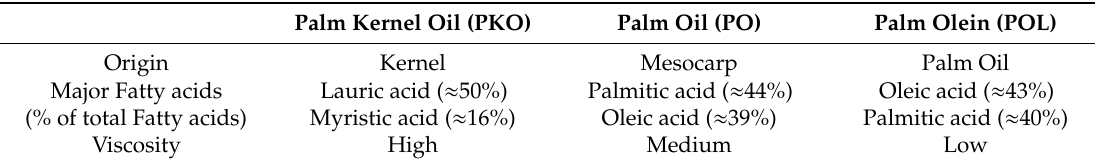
Table 1. Comparisons of the major palm tree derived